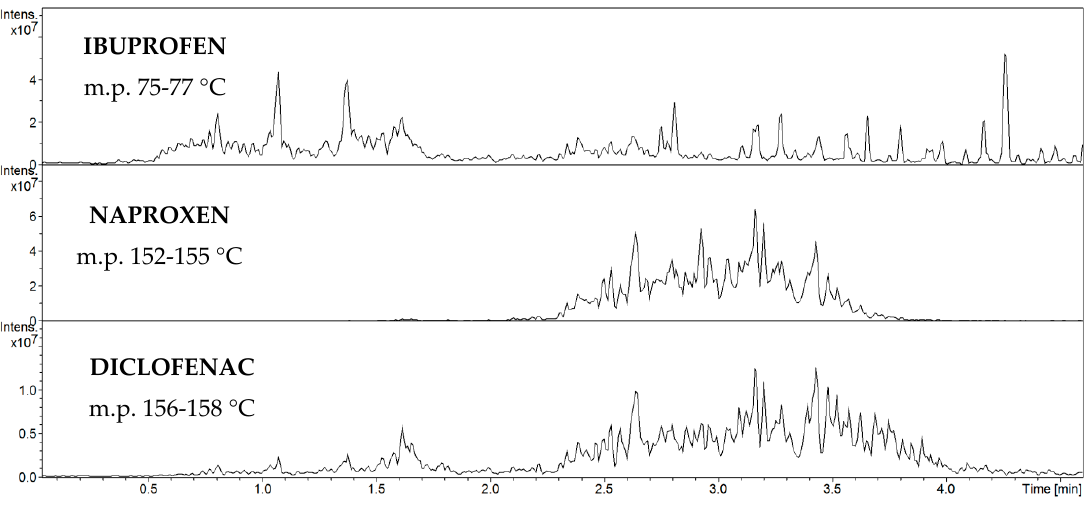
Figure 8. Total ion current chromatogram for FAPA ‐ MS analysis of ibuprofen, naproxen, and diclofenac.